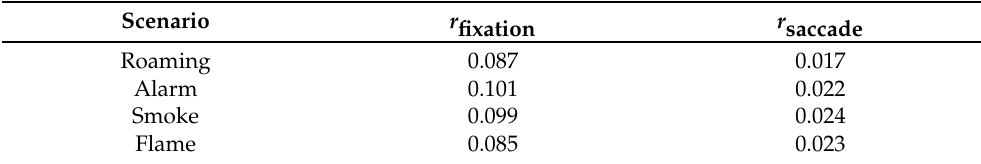
Table 10. Standard deviations of r fixation and r saccade.